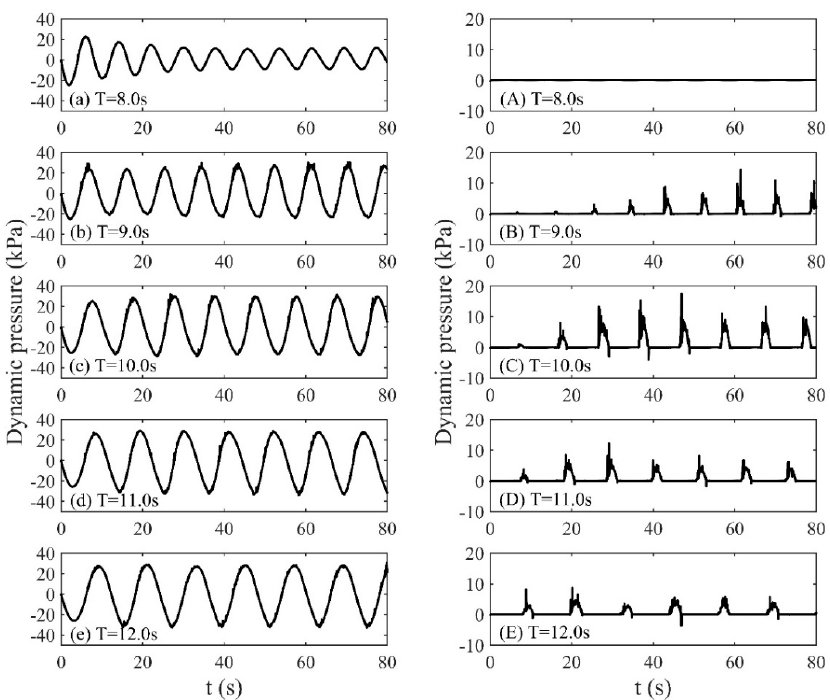
Figure 10. Comparisons of dynamic pressures among various forcing periods 8.0 s, 9.0 s, 10.0 s, 11.0 s and 12.0 s at P4 ( left column ) and P5 ( right column ).